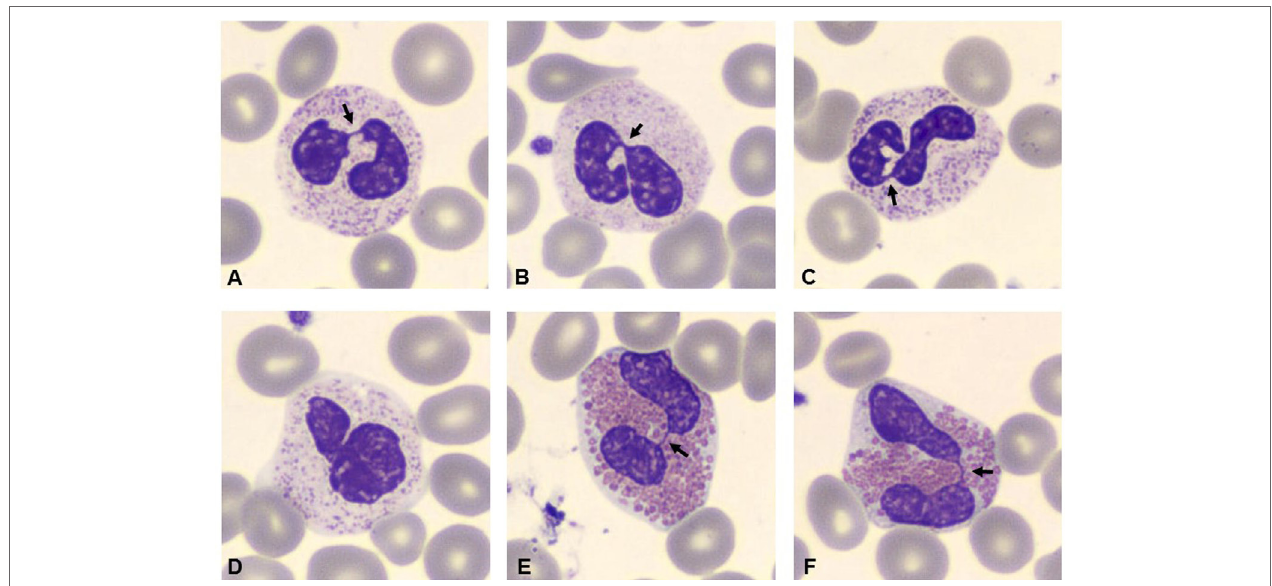
FIGURe 2 | Blood smear stained with Giemsa (100 × ) . Arrows indicate hyposegmentation of nuclei with chromatin filaments connecting the nuclear lobes in neutrophils (a–D) . Eosinophils showed the same chromatin filaments (e,F) .